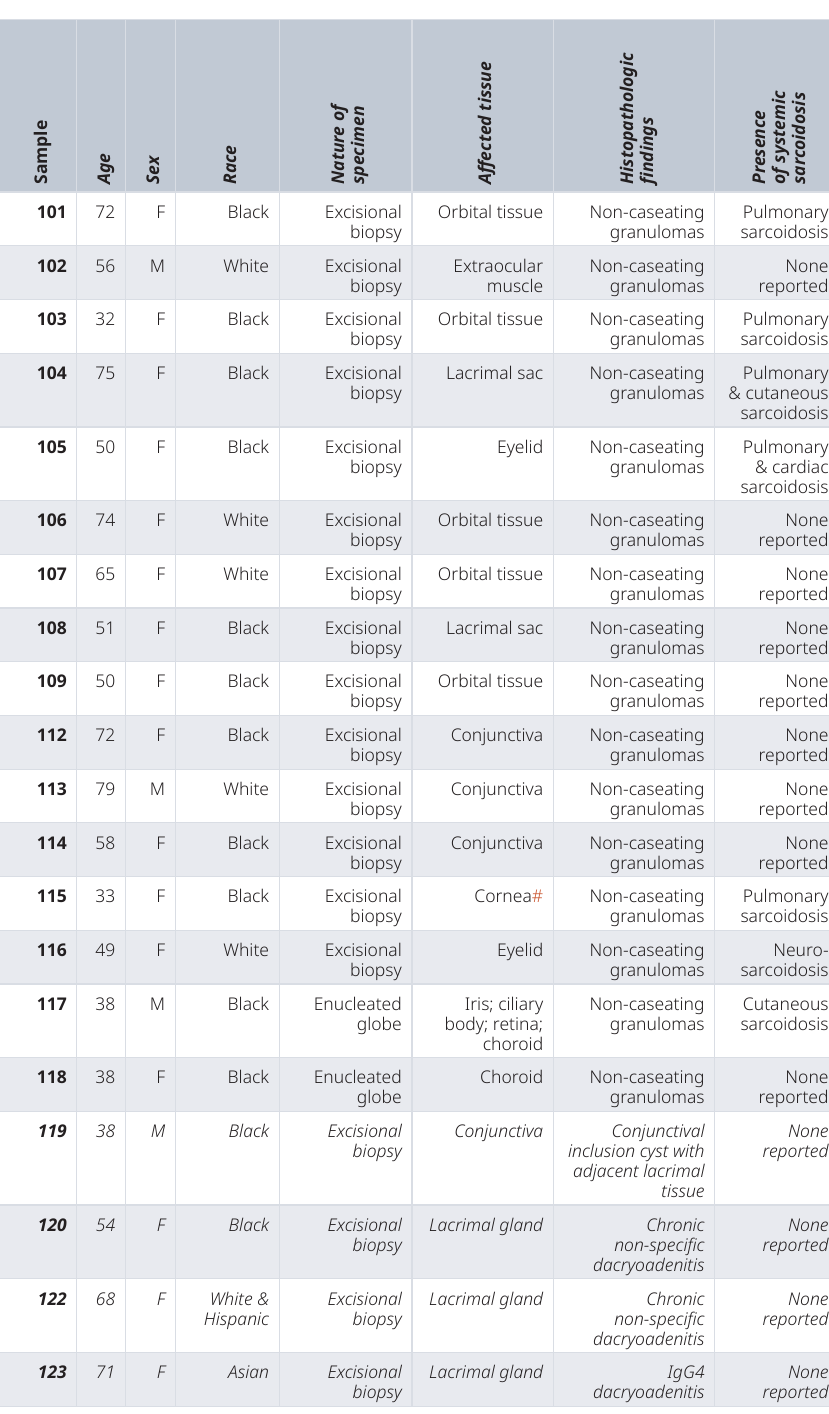
Table 2. Demographic and clinical data of the cases and controls*.